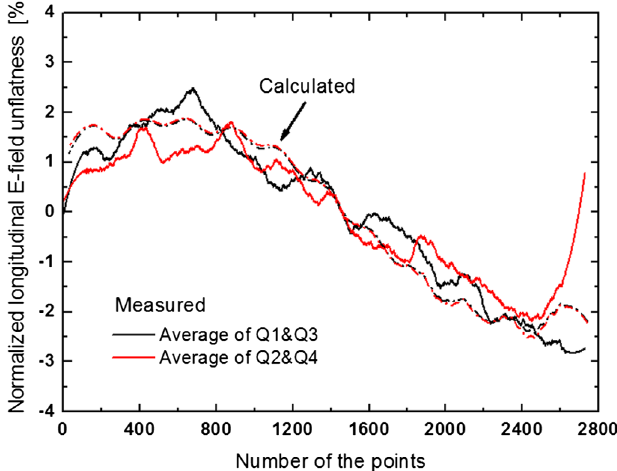
component.FIG. 18. The longitudinal unflatness of the electric field along the